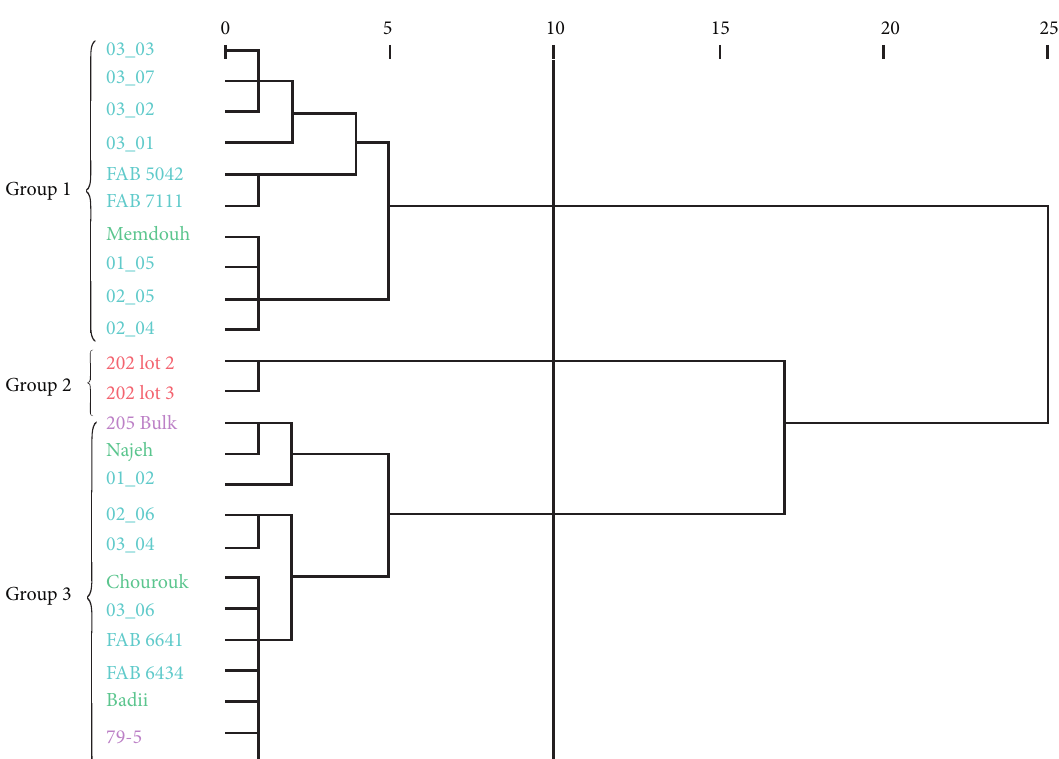
Figure 4: Classification of the studied faba bean germplasm accessions based on morphological characters using clustering by Euclidean